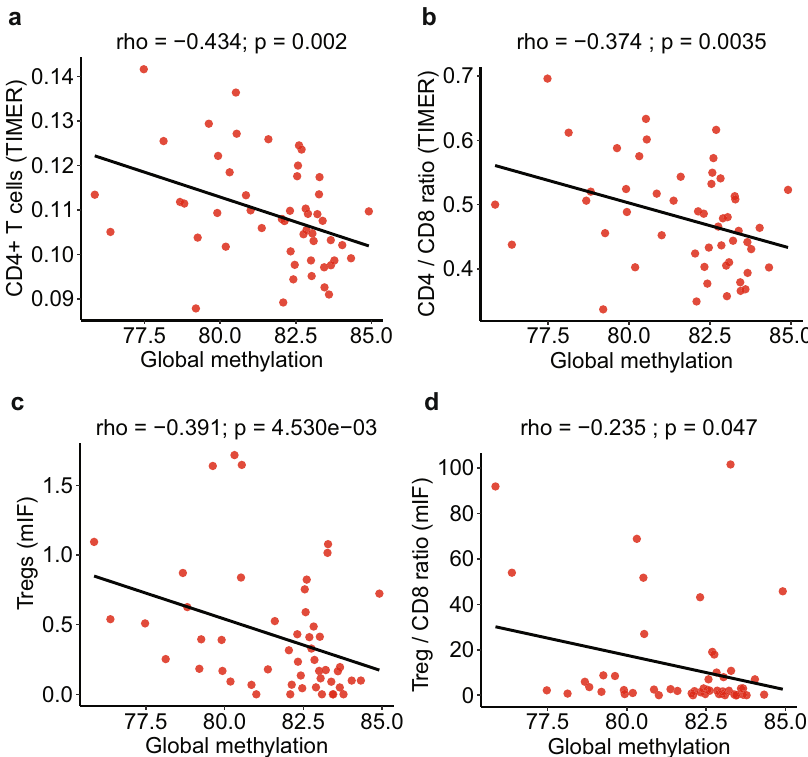
Fig. 6 The potential impact of global methylation and immune in fi ltration. The correlation between global methylation levels (using LINE-1 as a surrogate marker) with CD4 + T cells ( a ), CD4/CD8 ratio ( b ) inferred from immune gene expression by TIMER as well as Treg (CD3 + CD8 – FOXP3 + ) ( c ) and Treg (CD3 + CD8 − FOXP3 + )/CD8(CD3 + CD8 + ) ratio ( d ) measured by mIF. The correlation coef fi cient (rho) was assessed by two-tailed Spearman ’ s rank correlation test. Data from 24 patients was used including NL (normal lung tissue), AAH (atypical adenomatous hyperplasia), AIS (adenocarcinoma in situ), MIA (minimally invasive adenocarcinoma), and ADC (invasive adenocarcinoma). (Source data is provided as a source data fi